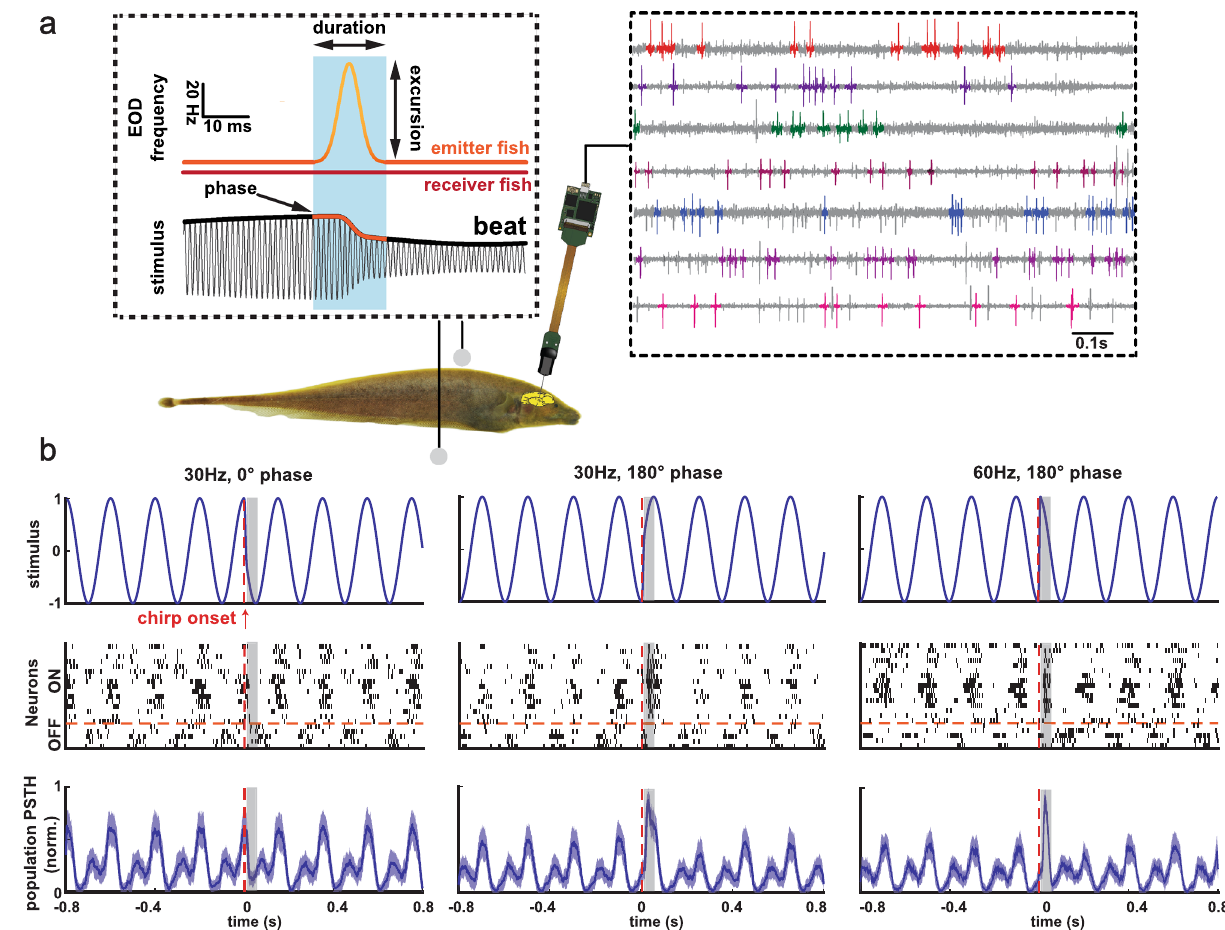
Figure 1. Neuropixels probes were used to record extracellular activities of ELL pyramidal cells responding to chirps created using adobe illustrator CS6 v 16.0 (www. adobe. com). ( a ) Left: schematics demonstrating chirps stimuli used in the experiments and experimental set up. Right: recorded activities from example channels using Neuropixels probes with spikes of different neurons highlighted in colors. ( b ) Left: stimulus waveform (top) consisting of a 5 Hz beat with a chirp (vertical red dashed line), raster plot of ON and OFF cells (middle), and the mean and standard deviation (shaded areas) of normalized population PSTHs across different trials (see “Materials and methods”) (bottom) for chirp with 30 Hz excursion frequency at 0° of beat phase. The grey rectangle indicates the 40 ms chirp evaluation time window. Middle: same plots for chirp with 30 Hz excursion frequency at 180° of beat phase. Right: same plots for chirp with 60 Hz excursion frequency at 180° of beat